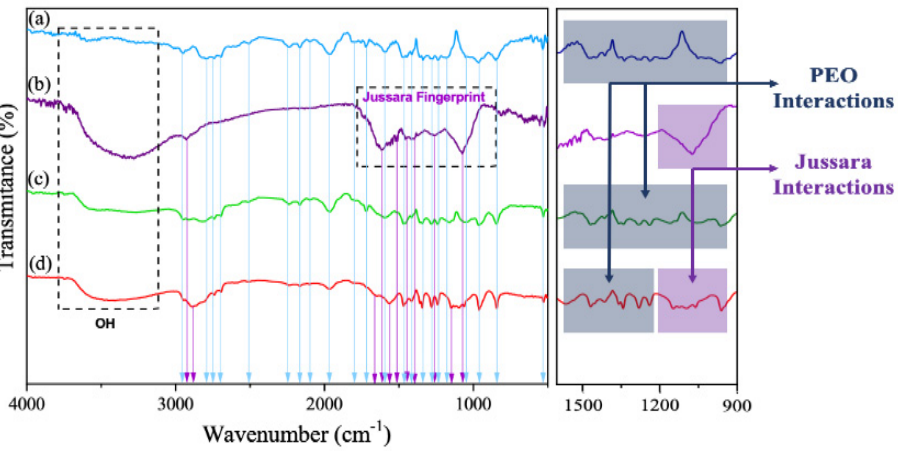
Figure 4. FTIR spectra: ( a ) PEO 8% sample, ( b ) jussara pulp, ( c ) PEO 8% and jussara sample (V2), and ( d ) PEO 8% and jussara sample (V4), at room temperature. Table 4. Wavenumbers and assignments of IR bands exhibited by samples V2 and V4. Where ν = stretch, δ = scissor/deformation, ω = wag, ρ = rock, τ = twist. The subscripts s and as refer to symmetric and asymmetric vibrational modes,